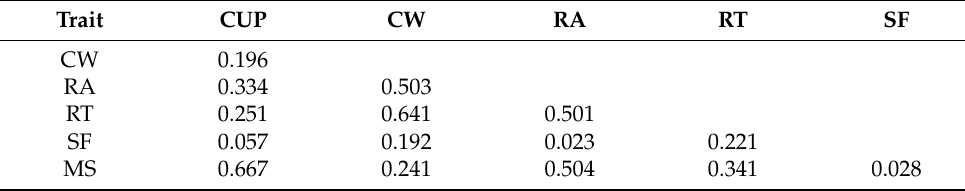
Figure 1. Values of calf market price (CaP) predicted from calf market weight (CaW) using the regression equation: CaP = 1.21 × 10 6 − 1.42 × 10 4 × CaW + 62.15 × CaW 2 − 0.08 × CaW 3 . Minimum and Maximum values for CaW are shown in Table 1. Table 4. Pearson’s correlation coefficients among carcass traits 1